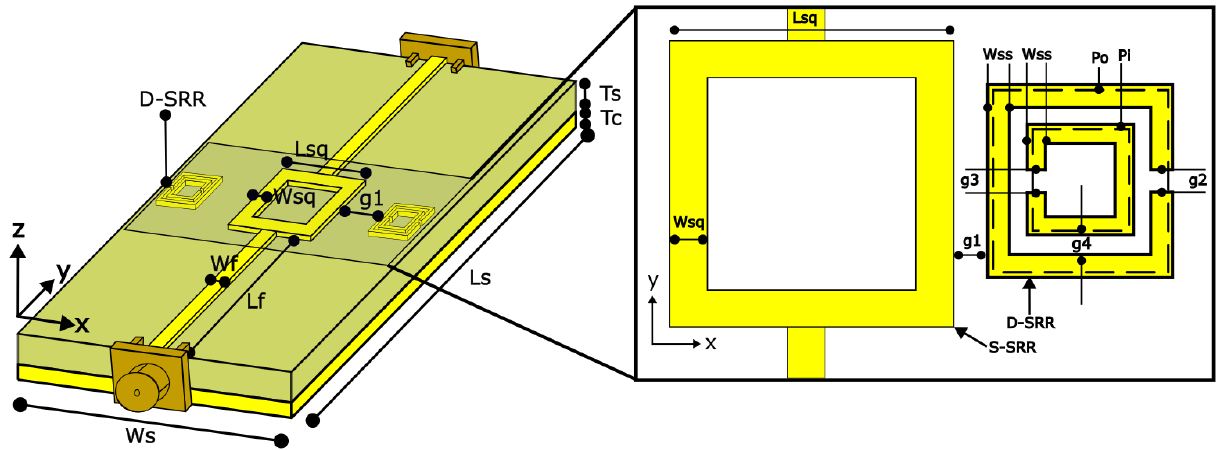
Figure 9. S-SRR edge coupled with D-SRR proposed structure.